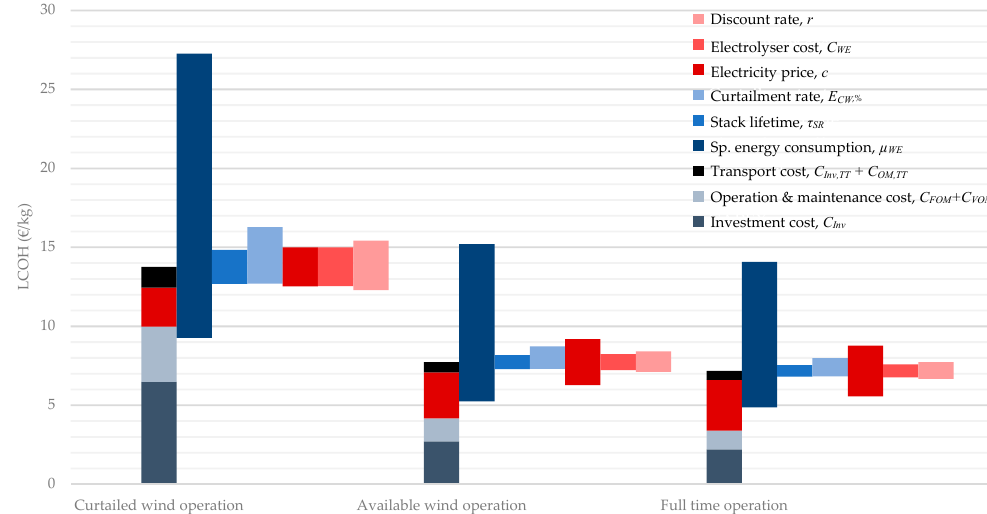
Figure 13. Sensitivity analysis of the techno-economic parameters.